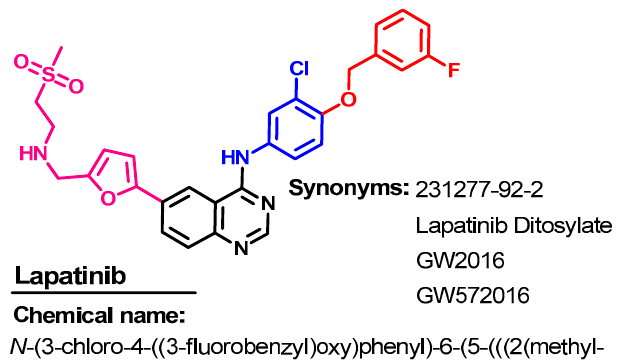
Figure 39. Chemical structure/name/synonyms of icotinib.